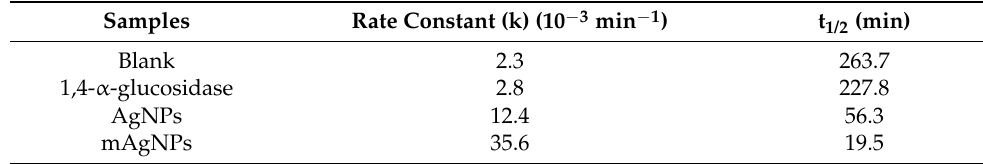
Figure 5. Plausible mechanism of the catalytic reduction of 4 − NA by NaBH 4 using AgNPs as a catalyst ( a ); catalytic reaction of 4 − NA after the addition of the AgNPs and mAgNPs as a func- tion of time and absorbance intensity at the maximum wavelength of 4 − NA ( b ); concentration of residual 4 − NA in solution ( c ) and efficiency percentage of the nanoparticles in the catalytic reaction of 4-nitroaniline ( d ). Table 1. Kinetic parameters for first-order reduction of 4 − NA catalyzed by